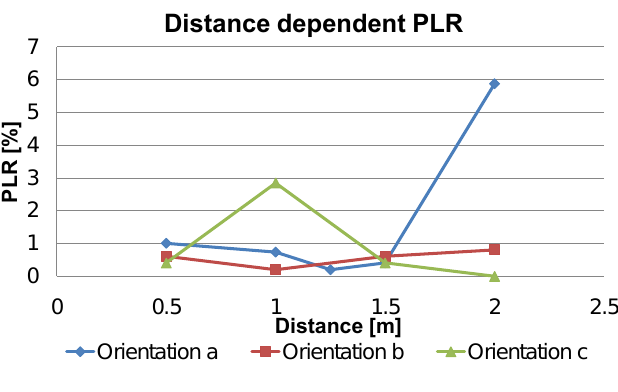
Figure 10. Packet loss rate (PLR) measurements using the three antenna alignments as described in Figure 6.